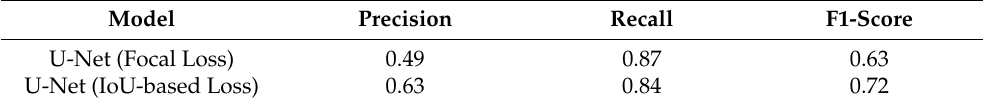
Figure 8. IoU-based Loss curve during training and validation. Table 1. U-Net model performance metrics considering different loss